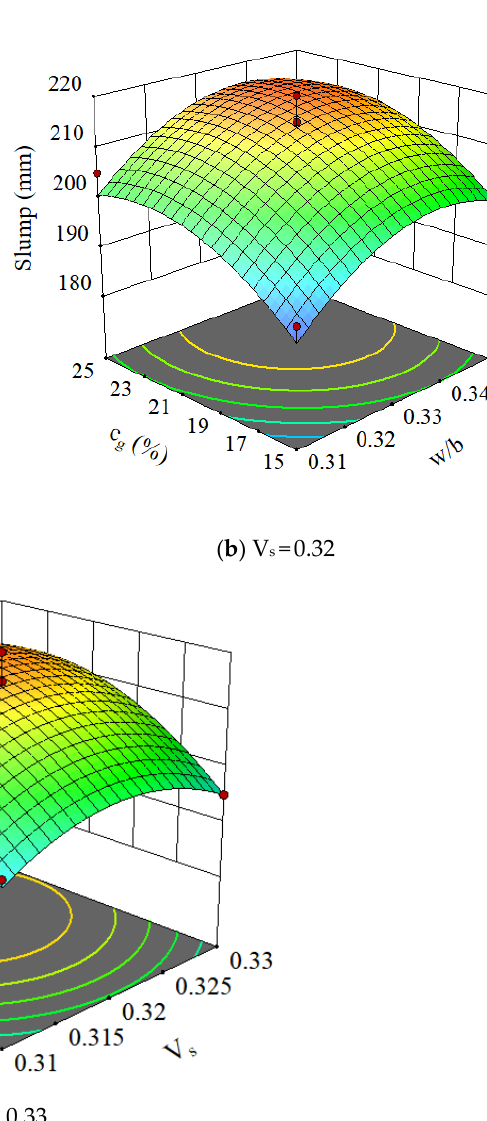
Figure 5. The 3D plots for slump of concrete.